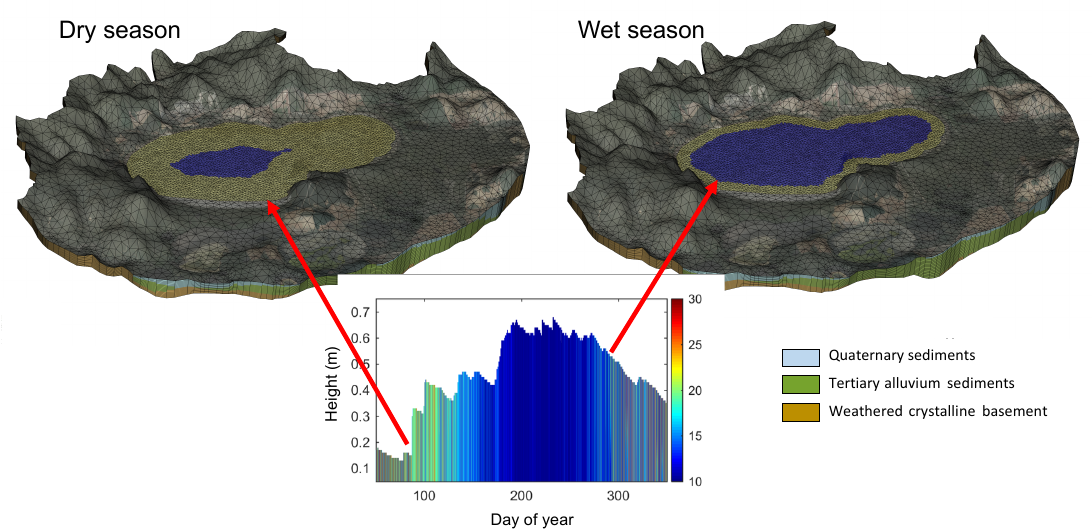
Figure 20. Example of water level changes during a seasonal cycle from Lake Muir, Australia. GLM water level is periodically communicated to the 3-D FEFLOW groundwater model via a plug-in calling libGLM and used as a constant head boundary condition for all wet cells within the FEFLOW